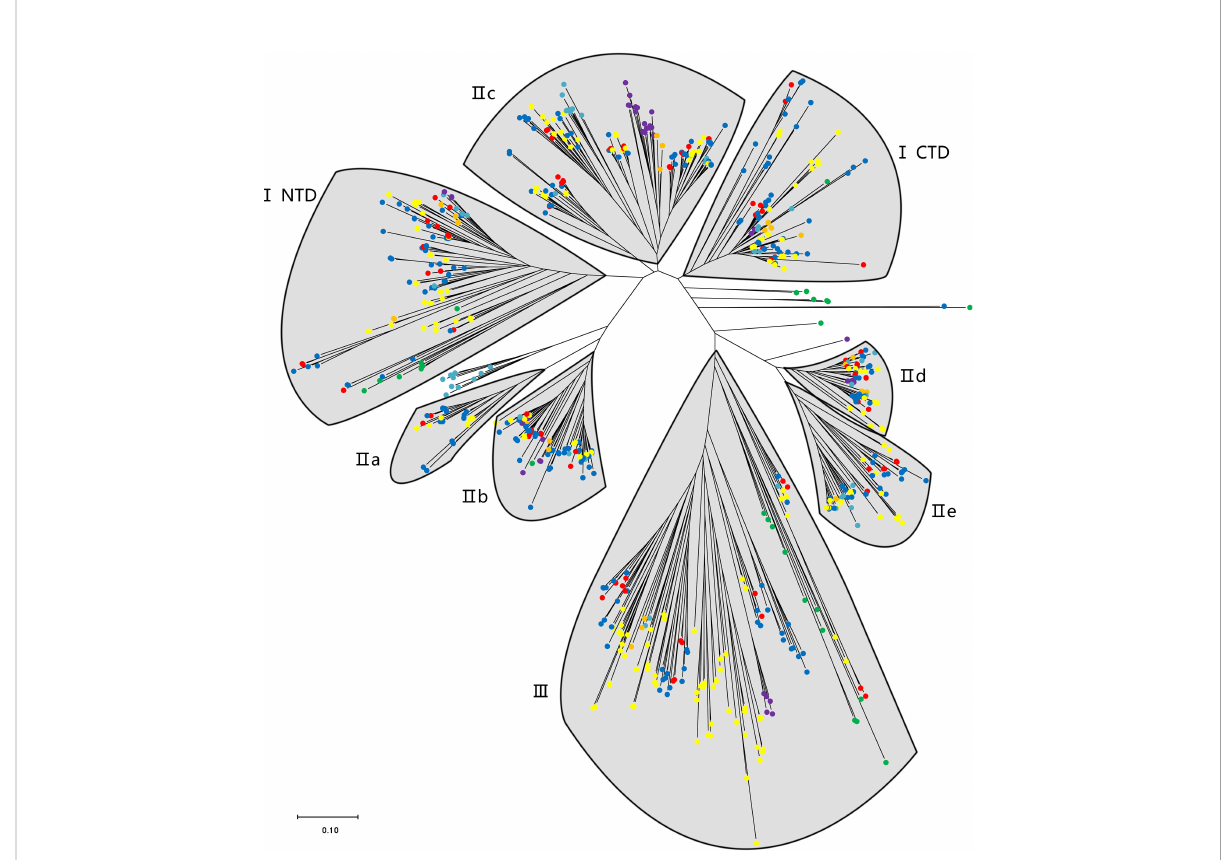
FIGURE 2 A phylogenetic tree of WRKY domains from T. sinensis and other species in the green lineage. The phylogenetic tree was derived from a MUSCLE alignment of WRKY domains from the following species: Micromonas pusilla , Ostreococcus tauri , Ostreococcus lucimarinus , Dunaliella salina , Chlamydomonas reinhardtii , Gonium pectorale , Volvox carteri , Physcomitrella patens , Selaginella moellendorf fi i , Brachypodium distachyon , Oryza sativa , Glycine max , Arabidopsis thaliana , and T. sinensis . The green, purple, orange, indigo, yellow, blue, and red dots represent unicellular green algae, bryopsida, pteridophyta, gymnosperms, monocotyledons, dicotyledons, and T. sinensis,